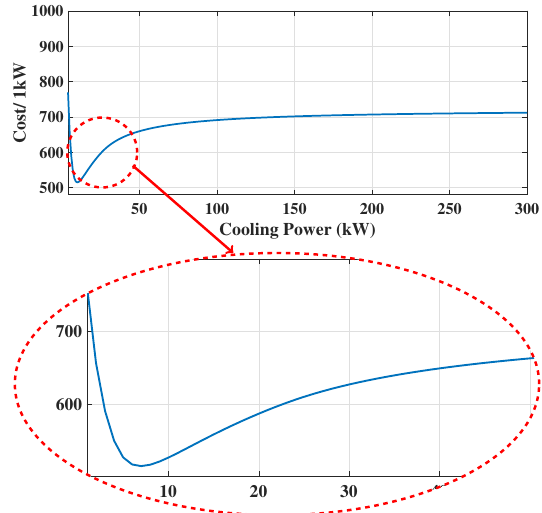
Figure 5. Cost per 1 kW versus different cooling power.